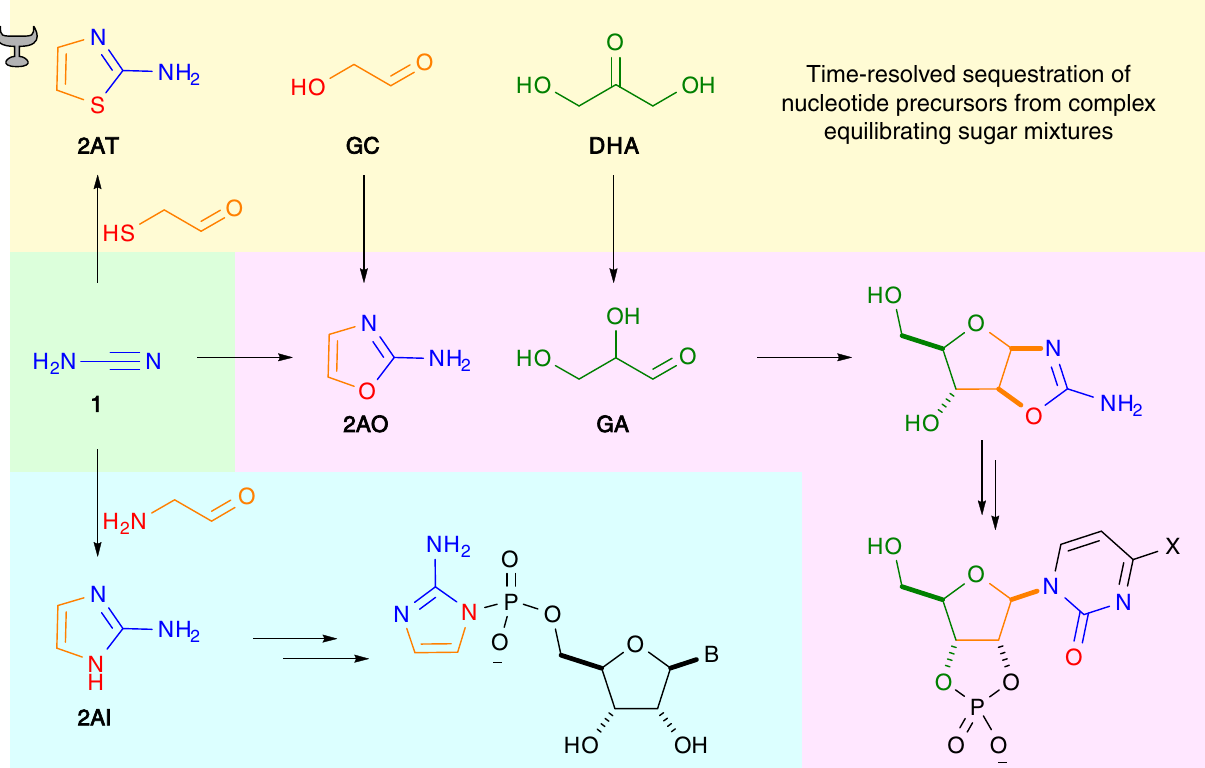
Fig. 2 The roles of 2-aminoazoles in prebiotically plausible nucleotide chemistry. Green: Divergent synthesis of 2-aminothiazole ( 2AT ), 2-aminooxazole ( 2AO ) and 2-aminoimidazole ( 2AT ) from cyanamide ( 1 ). Yellow: Crystallisation-controlled aldehyde sequestration by 2-aminothiazole ( 2AT ) giving access to pure glycolaldehyde ( GC ) and glyceraldehyde ( GA ), in the order required for selective nucleotide synthesis, from equilibrating sugar mixtures. Pink: Prebiotically plausible pyrimidine nucleotide synthesis. Cytidine X = NH 2 , uridine X = OH. Blue: Nucleoside-5 ′ -phosphorimidazolide activation with 2- aminoimidazole ( 2AI ). B =